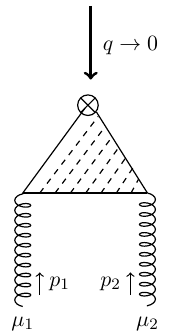
Figure 2 . The kinematic configuration selected for the computations of matrix elements of the operators appearing in the axial-anomaly